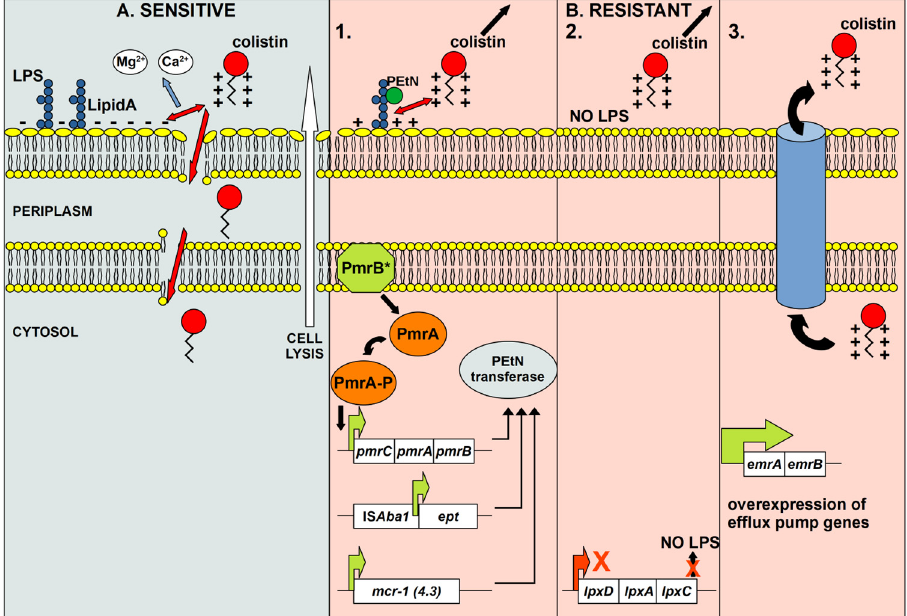
Figure 1. Schematic representation of the mode of action of colistin in susceptible cells ( A ) and the molecular mechanisms of resistance to colistin in resistant cells ( B ). A—Colistin causes lysis of susceptible cells due to induced disruption of the outer and inner membranes. Initial interactions between the positively charged moiety of colistin and the negatively charged phosphate groups of lipid A of LPS lead to the displacement of calcium and magnesium cations affecting the LPS structure. In the next step, the hydrophobic acyl fatty chain of colistin penetrates the outer membrane leading to its permeabilization. As a result of permeabilization, colistin penetrates the inner membrane and alters it integrity, leading to leakage of intracellular material and cell death. B—Resistance to colistin arises through several common mechanisms. 1. As a result of PEtN moiety addition to lipid A (mutations and overexpression of pmrCAB , eptA , or presence of plasmid-mediated mcr genes), the overall charge of the outer membrane changes so that colistin can no longer interact with lipid A of LPS. 2. Inactivation of the LPS biosynthetic pathway results in the absence of LPS, the target molecule for colistin. 3. Overexpression of specific efflux pumps leads to efficient extrusion of colistin, resulting in resistance.